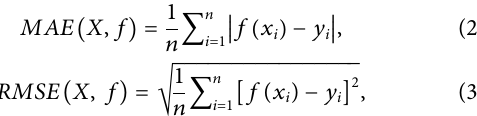
Frontiers in Physiology |